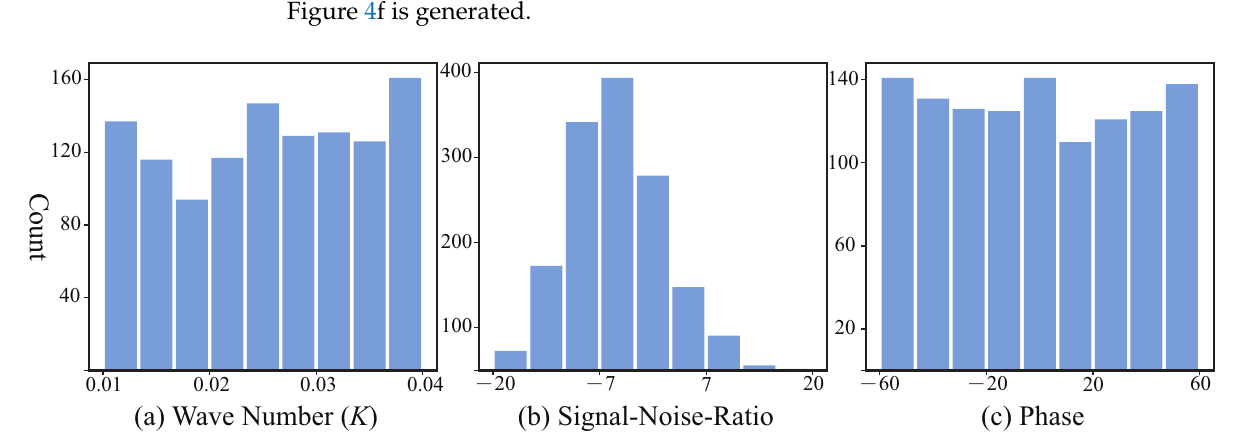
Figure 5. Distributions of wavelet factors, ( a ) K conform to a uniform distribution, ( b ) SNR conform to positive-skewed distribution because the energy of the noise is commonly stronger than the signal in the field cases, ( c ) P conform to a uniform distribution.